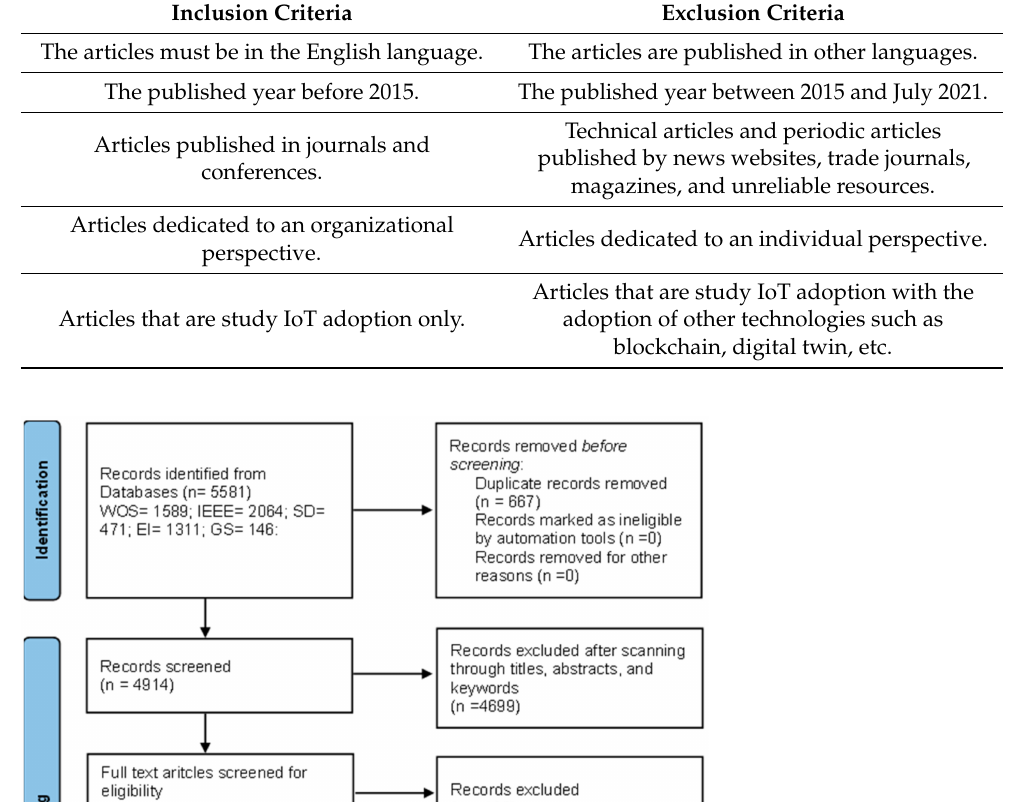
Table 2. Inclusion and exclusion criteria.